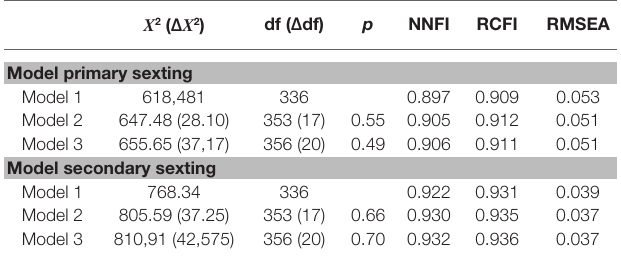
Model 1: Configural invariance. Model 2: Measurement invariance (equal factor loadings). Model 3: Structural model invariance (equal factor loadings, factor variances, and covariances). Χ 2 , Chi square statistic; df, degrees of freedom; NNFI, non-normed fit index; RCFI, robust comparative fit index; RMSEA, root mean-square error